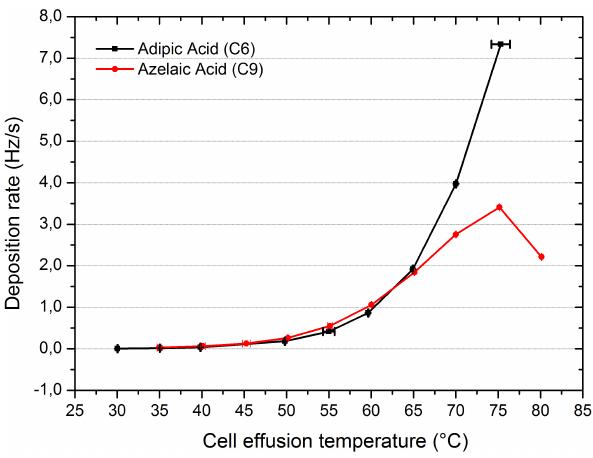
Figure 6. Black curve: deposition rate curve of adipic acid shows an increase up to 75 ◦ C without a decrease at higher temperature (an oscillation around an average value would be observed at even larger temperatures). Red curve: deposition rate curve of azelaic acid: molecules flux is small at low temperature as for the adipic acid case and contrarily to oxalic and succinic acids that show high sublimation rates at these low temperature, i.e. 25–30 ◦ C (weak in- termolecular